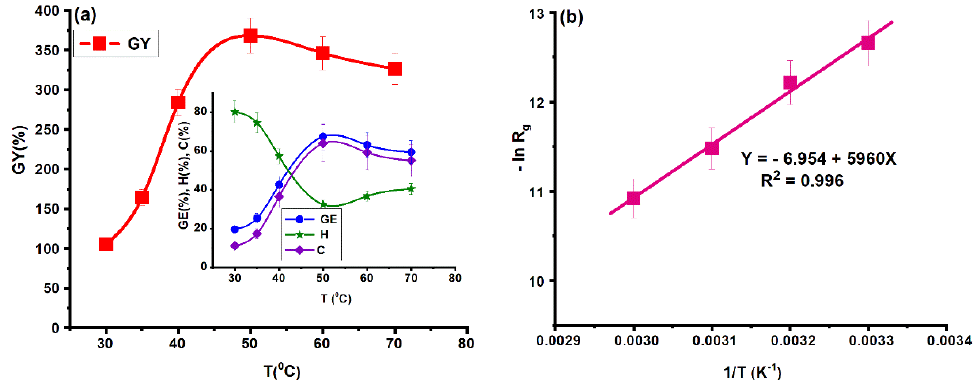
Figure 3. Influence of temperature on grafting of N -vinylimidazole (NVI) onto gellan gum ( a ) (c i = 0.08 mol/L; c m = 0.8 mol/L; c p = 8 g/L and t r = 4 h) and ( b ) the activation energy of the grafting reaction.